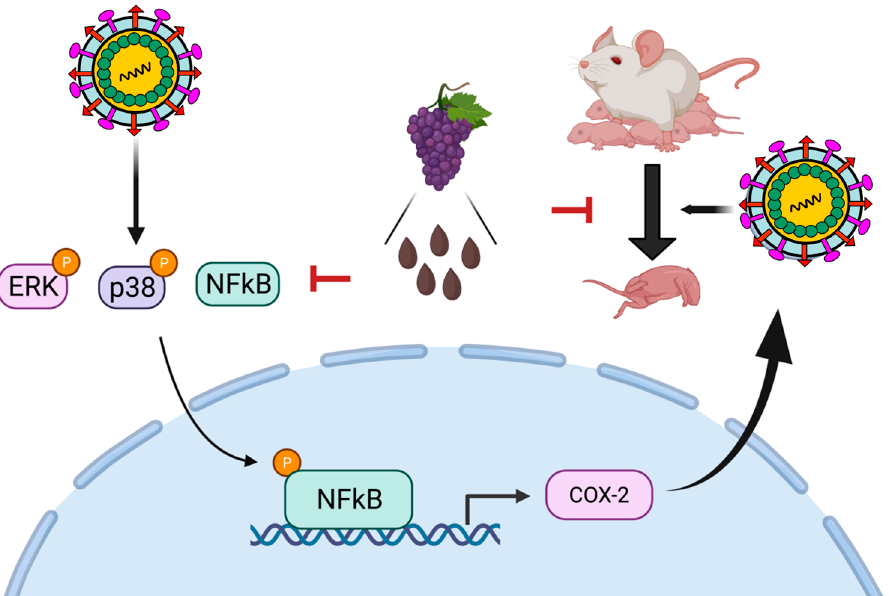
Figure 6. Proposed model illustrating the inhibitory mechanism of GSPE on DENV replication and the DENV-induced inflammatory response. GSPE suppresses DENV replication by downregulating COX-2 expression and reducing activity in the NF- κ B and MAPK/ERK/P38 signaling pathways, ultimately reducing the threat of death from dengue infection in DENV-infected mice.